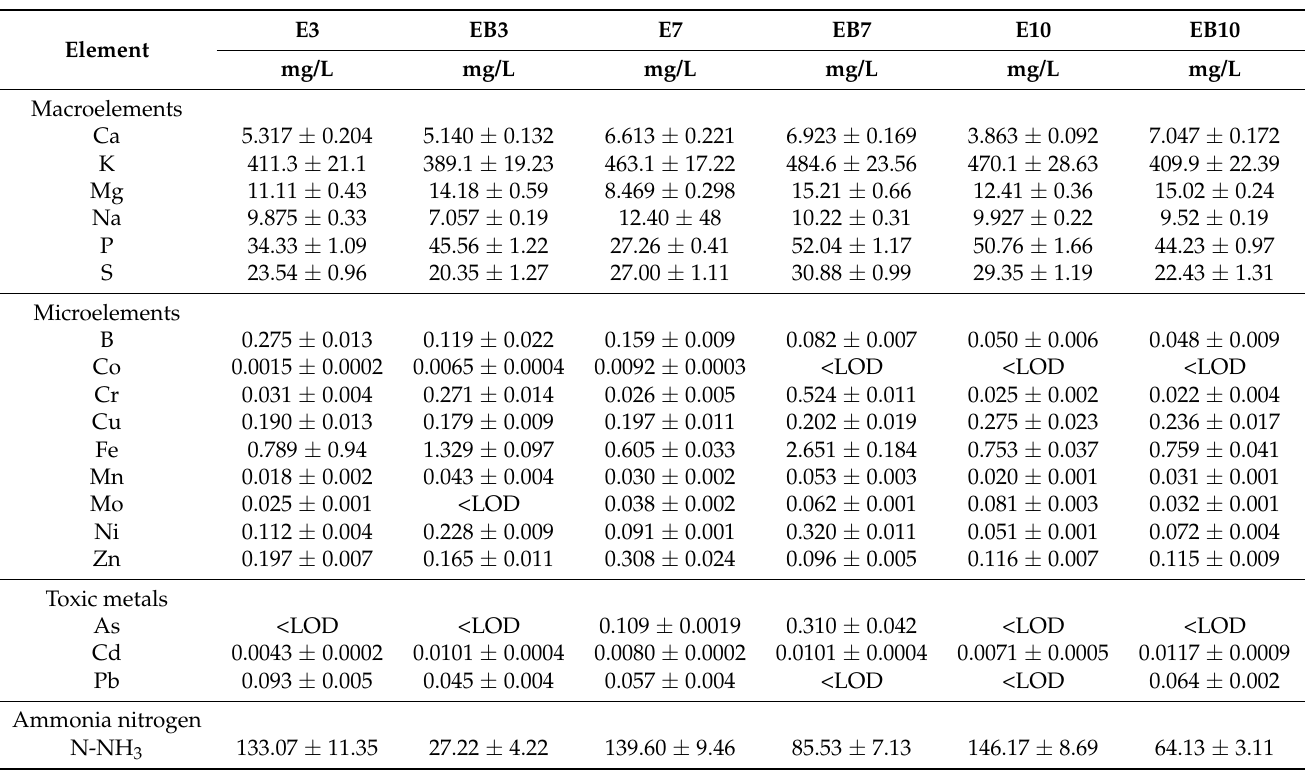
Table 4. The elemental composition of B. bassiana extracts. The table presents the content of micronu- trients, macronutrients, toxic metals, and ammonia nitrogen in the tested extracts (E3—aqueous extract obtained at 25 ◦ C pH = 3, EB3—aqueous extract obtained at 75 ◦ C pH = 3, E7—aqueous